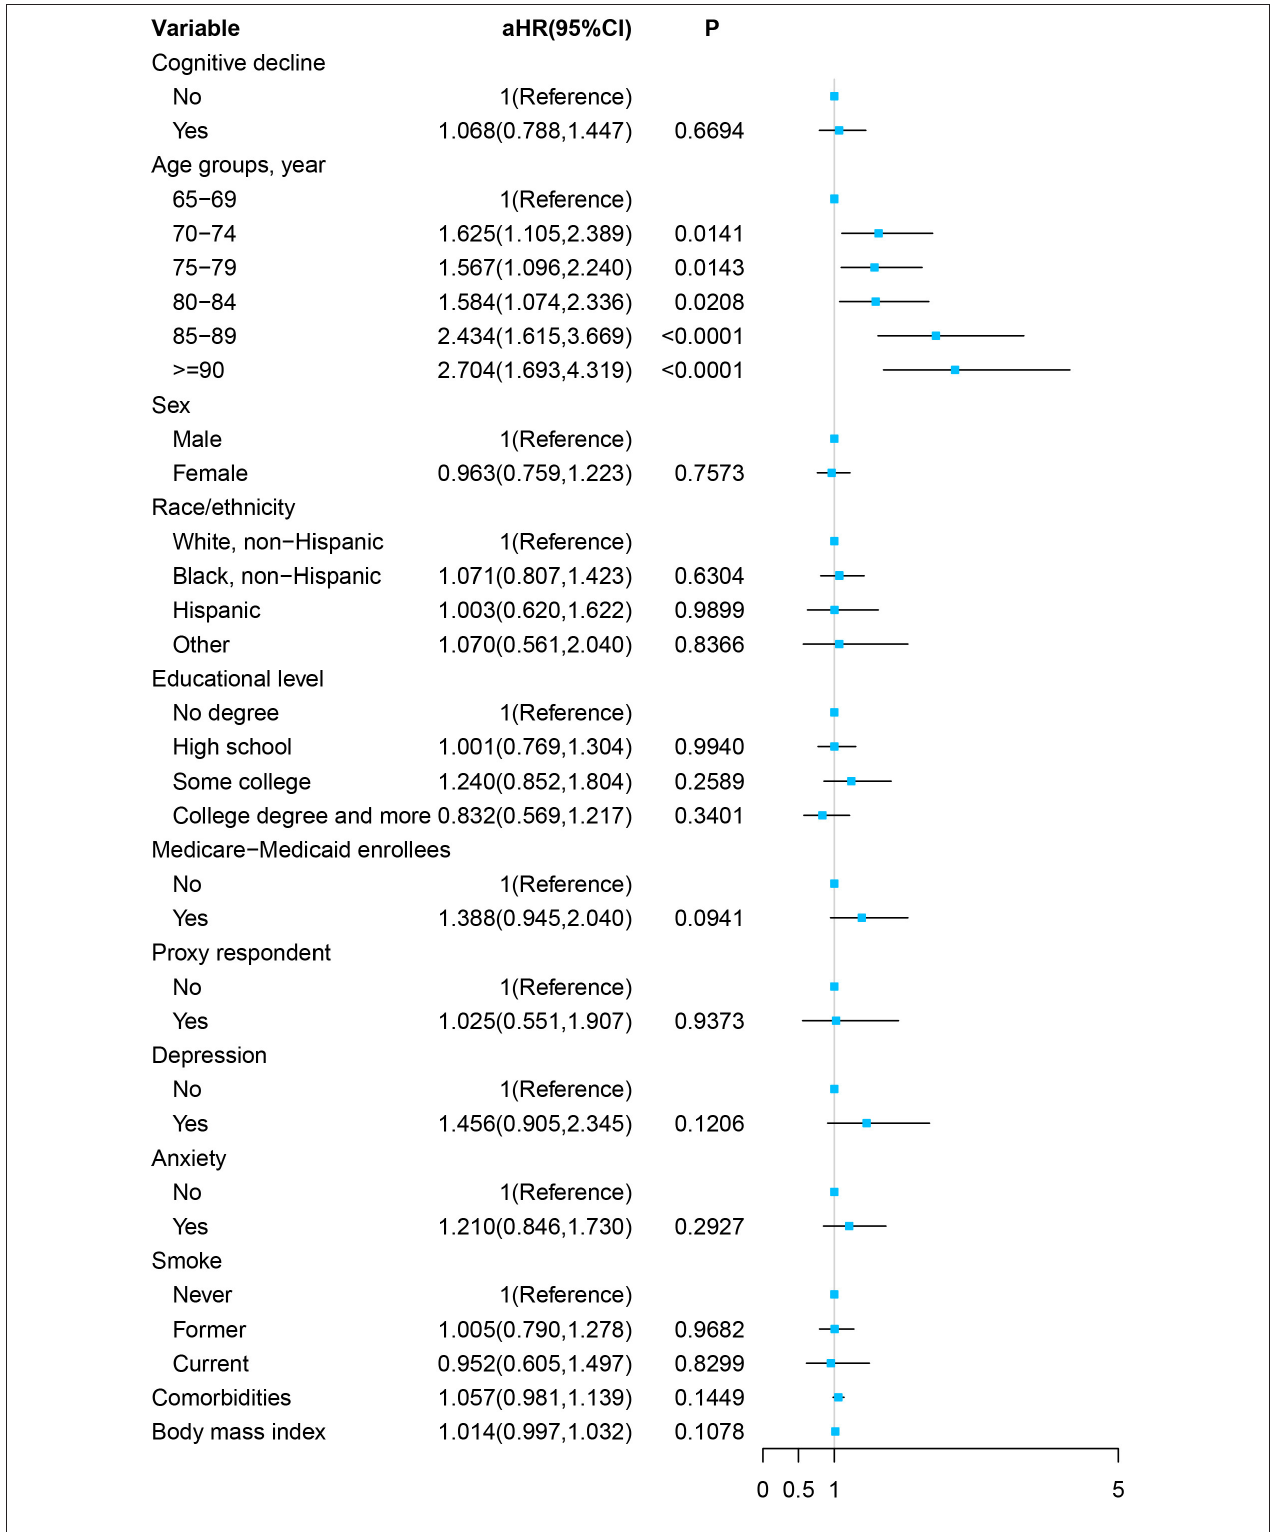
FIGURE 4 | Forest plot of multivariable proportional hazards regression modeling the development of stroke over 8 years of follow-up.